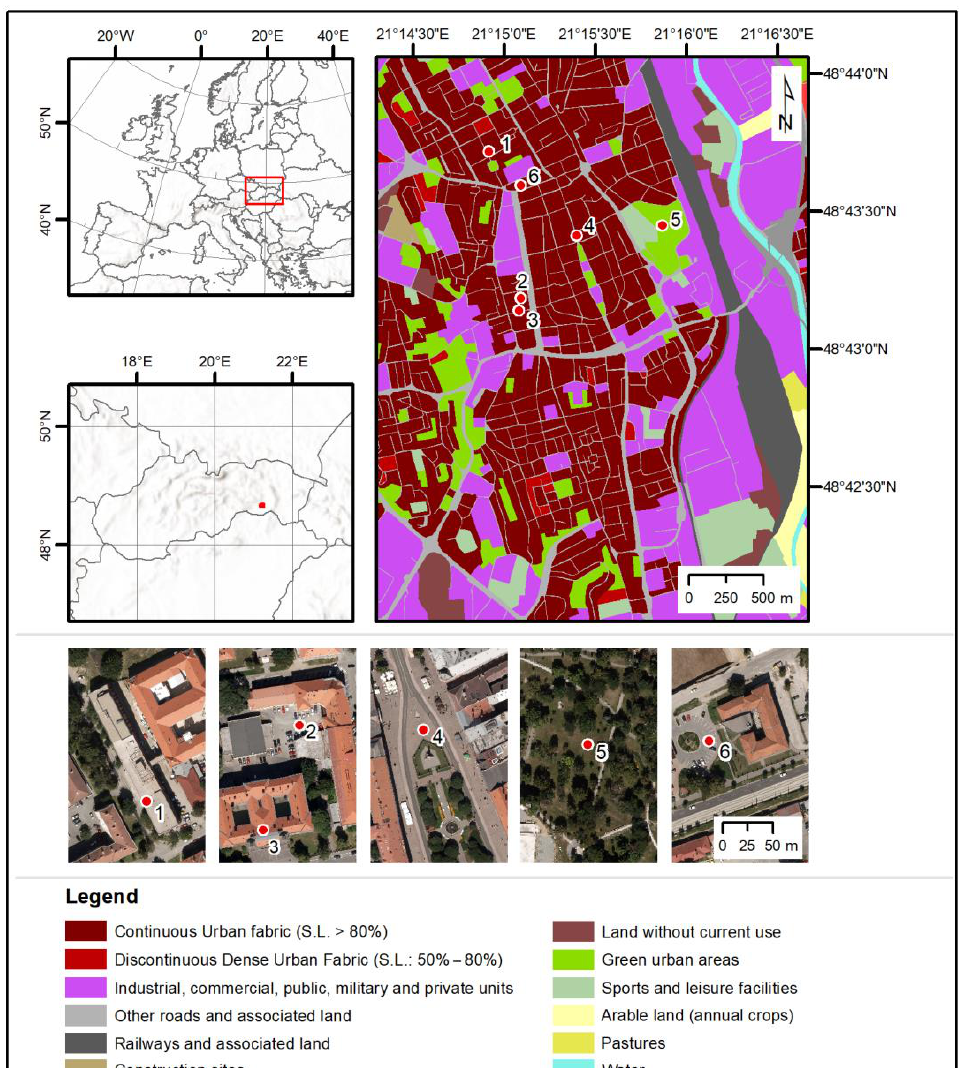
Figure 1. Location of the study area and the field sites of surface temperature measurements used to validate the results of LST downscaling. The background maps are © Copernicus Land Monitoring Service (Urban Atlas 2012) with funding by the European Union [35]; natural color orthoimage acquired on 9 August 2016 by Photomap.